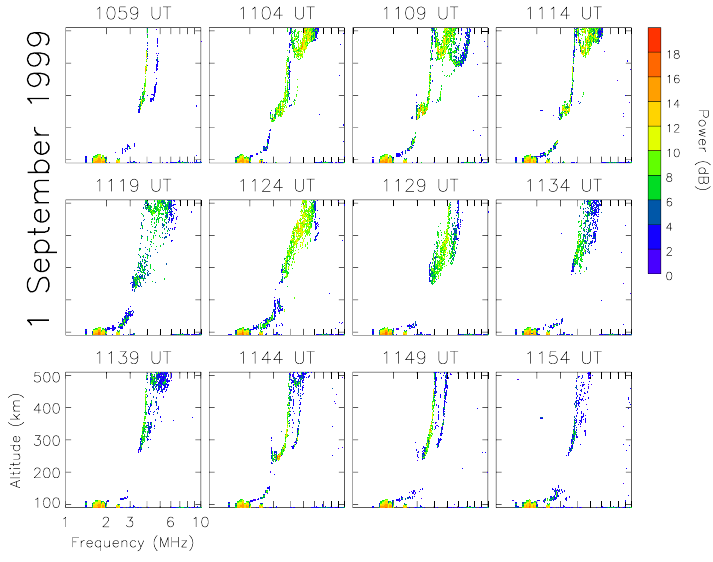
Fig. 8. A sequence of 12 ionograms from the Longyearbyen ionosonde, covering the interval over which the 1 September 1999 polar patch was ob- served by the